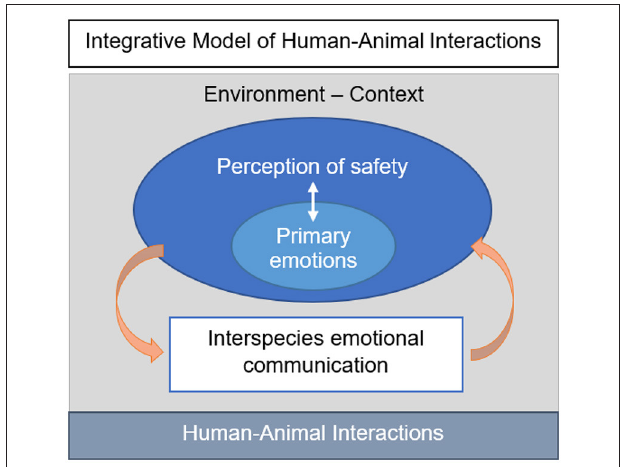
FIGURE 2 | Diagram of the integrative model of human–animal interactions.